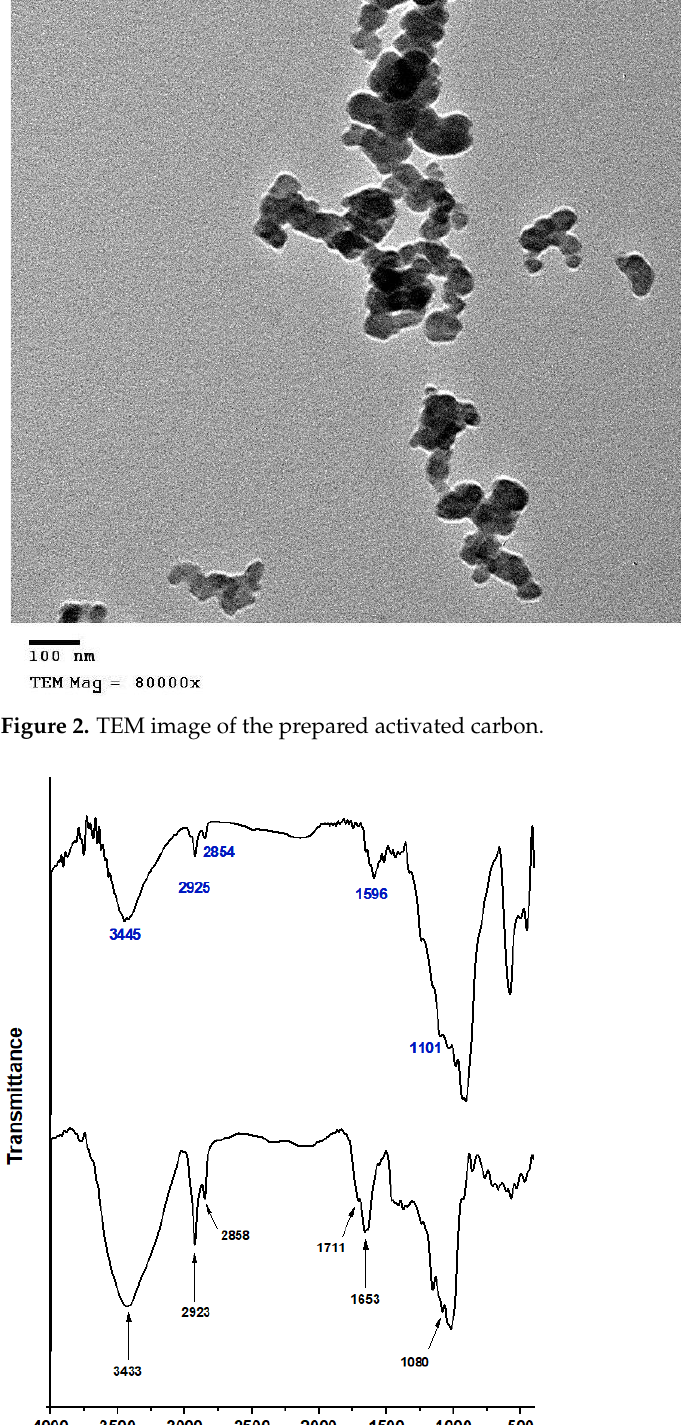
Figure 3. FT-IR spectrum of native rice husk and the activated carbon prepared from rice husk.